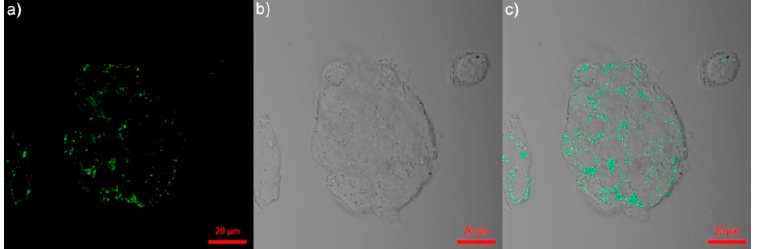
Figure 10. Confocal microscopic images of Hep G2 cells after incubation with C13 (noted as “ Py-Lac ” in the original report) (10 µM) for 2 h (( a ) excited at 780 nm, ( b ) bright field and ( c ) merged image of ( a , b )) (reproduced with the permission from Ref. [82]).